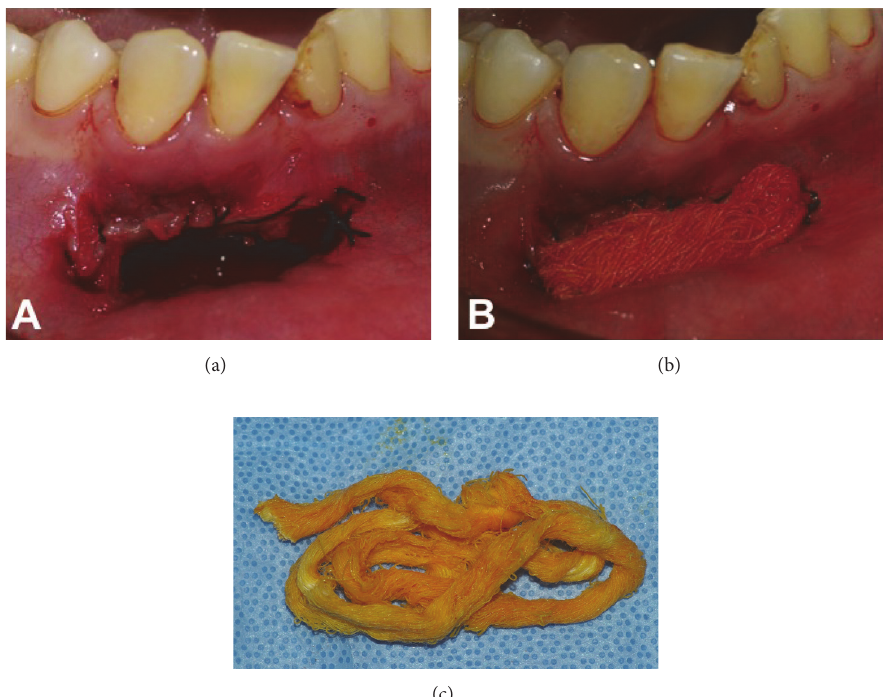
Figure 2: Surgical access through the anterior mandible for decompression of periapical lesion. (a) Cavity after packing (b) with gauze impregnated with antibiotic ointment (c).